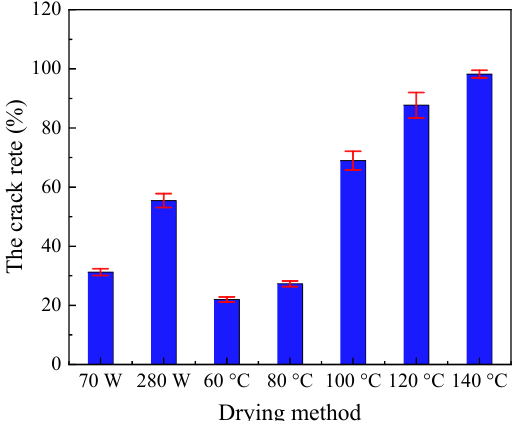
Processes 2021 , 9 , x FOR PEER REVIEW